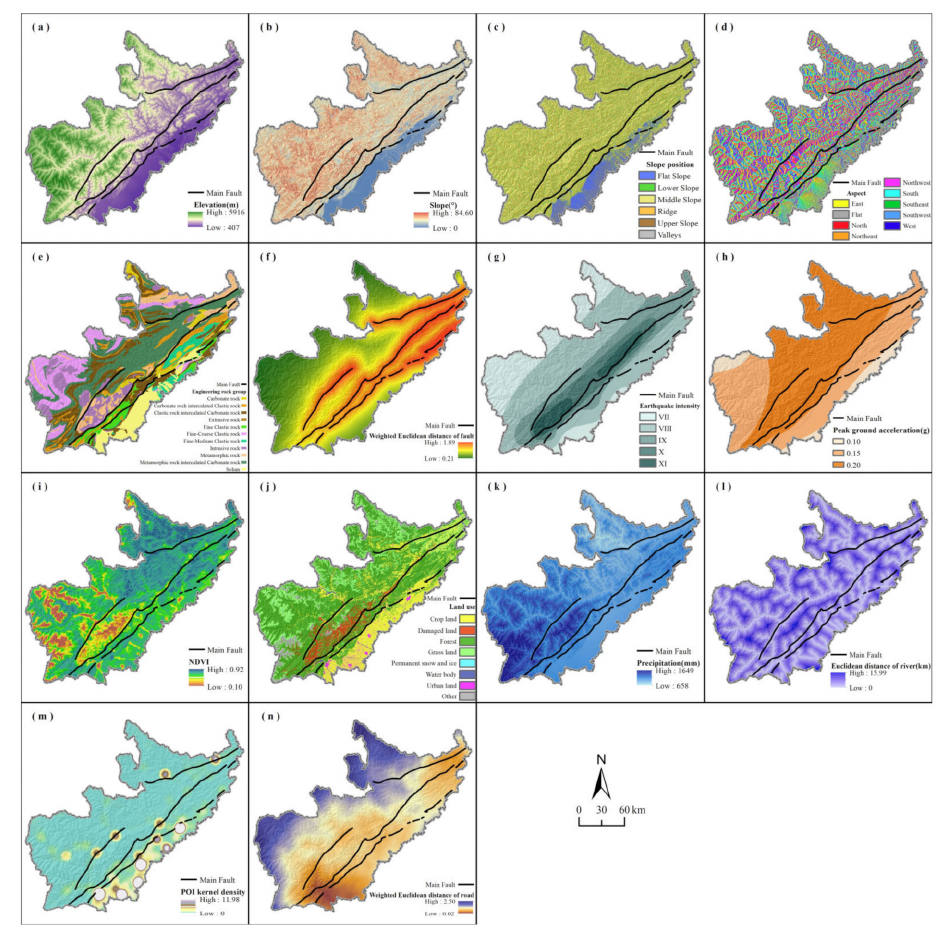
Figure 3. Thematic maps of impact factors: ( a ) elevation; ( b ) slope; ( c ) slope position; ( d ) aspect; ( e ) engineering rock group; ( f ) weighted Euclidean distance of fault; ( g ) earthquake intensity; ( h ) peak ground acceleration; ( i ) NDVI; ( j ) land use; ( k ) precipitation; ( l ) Euclidean distance of river; ( m ) POI kernel density; and ( n ) weighted Euclidean distance of